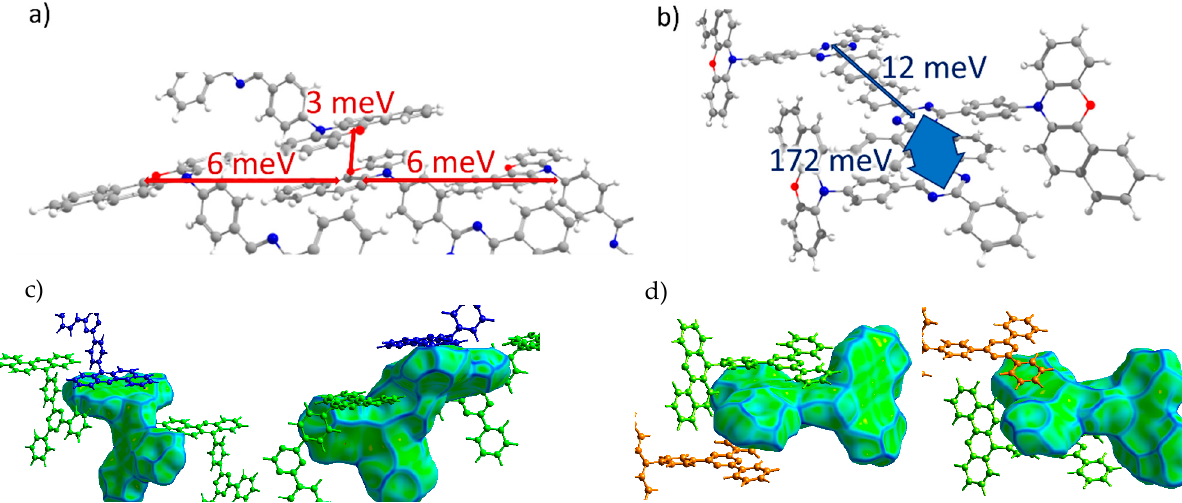
Figure 6. Charge transfer integrals for hole ( a ) and electron ( b ) transport in TRZ-c-BPXZ crystal. ( c , d ) Intermolecular contacts that enable these transfer integrals; the left picture corresponds to the contact that provided a larger J , while the right picture corresponds to the contact that provided a smaller J. The Hirshfeld surface for the central molecule was mapped with curvedness. The coloring corresponds to Figure 2.